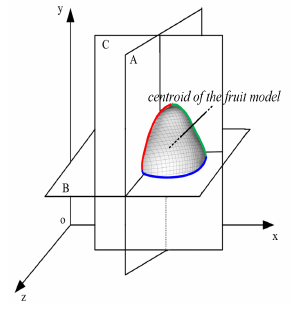
Figure 7. Section coordinate system of plane A , B , and C tangent to the fruit model by the